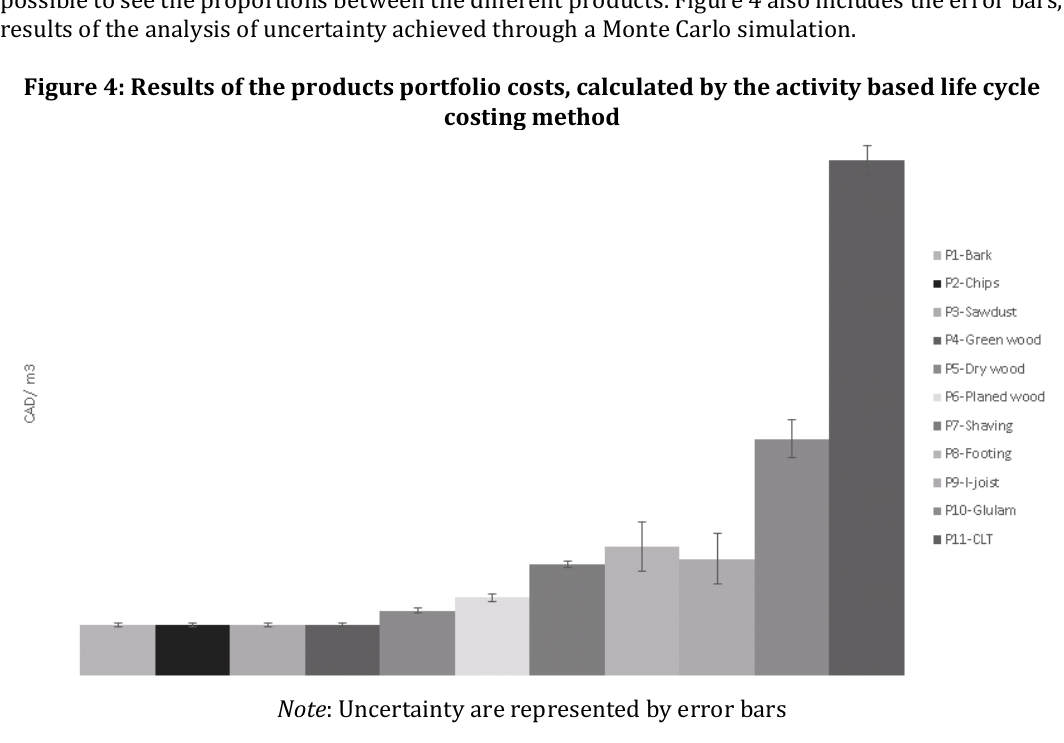
Note : Uncertainty are represented by error